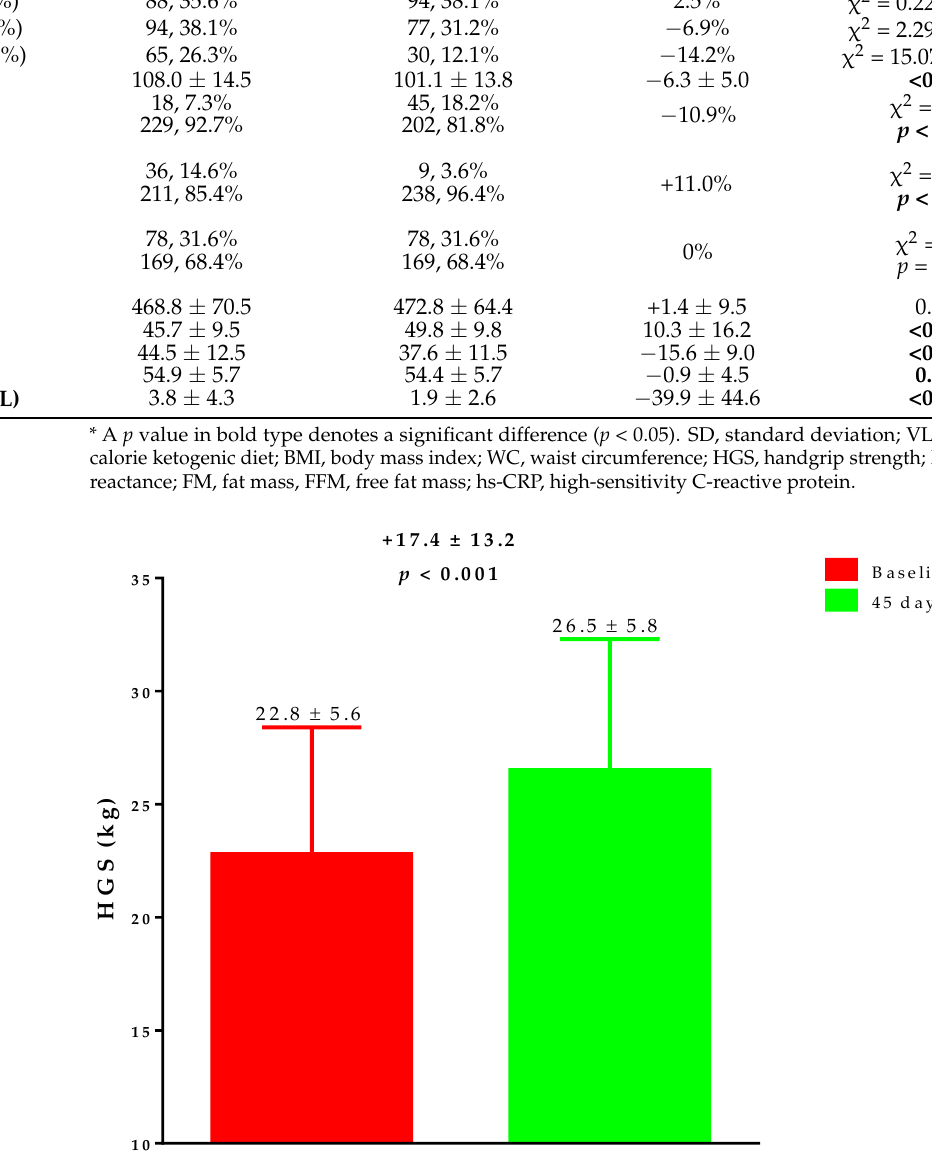
Figure 1. The change in HGS during the 45 days of active phase VLCKD. After 45 days of VLCKD, HGS measures were significantly increased ( p < 0.001). VLCKD, very low-calorie ketogenic diet; HGS, handgrip strength.